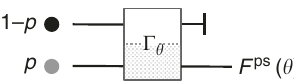
Fig. 1 Classical experiment with postselection. A nonoptimal input device initializes a particle in one of two states, with probabilities p and 1 − p , respectively. The particle undergoes a transformation Γ θ set by an unknown parameter θ . Only the part of the transformation that acts on particles in the lower path depends on θ . If the fi nal measurement is expensive, the particles in the upper path should be discarded: they possess no information about θ